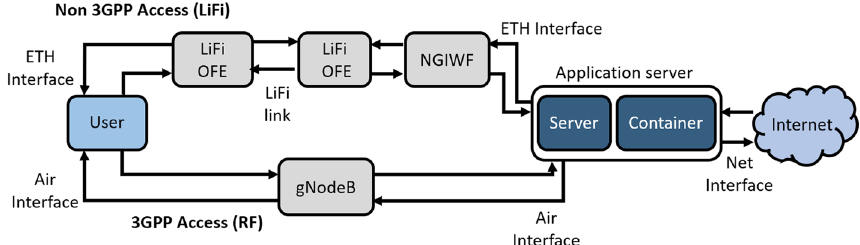
Fig. 11 LiFi-5G integration, as experimentally implemented at test set-up in